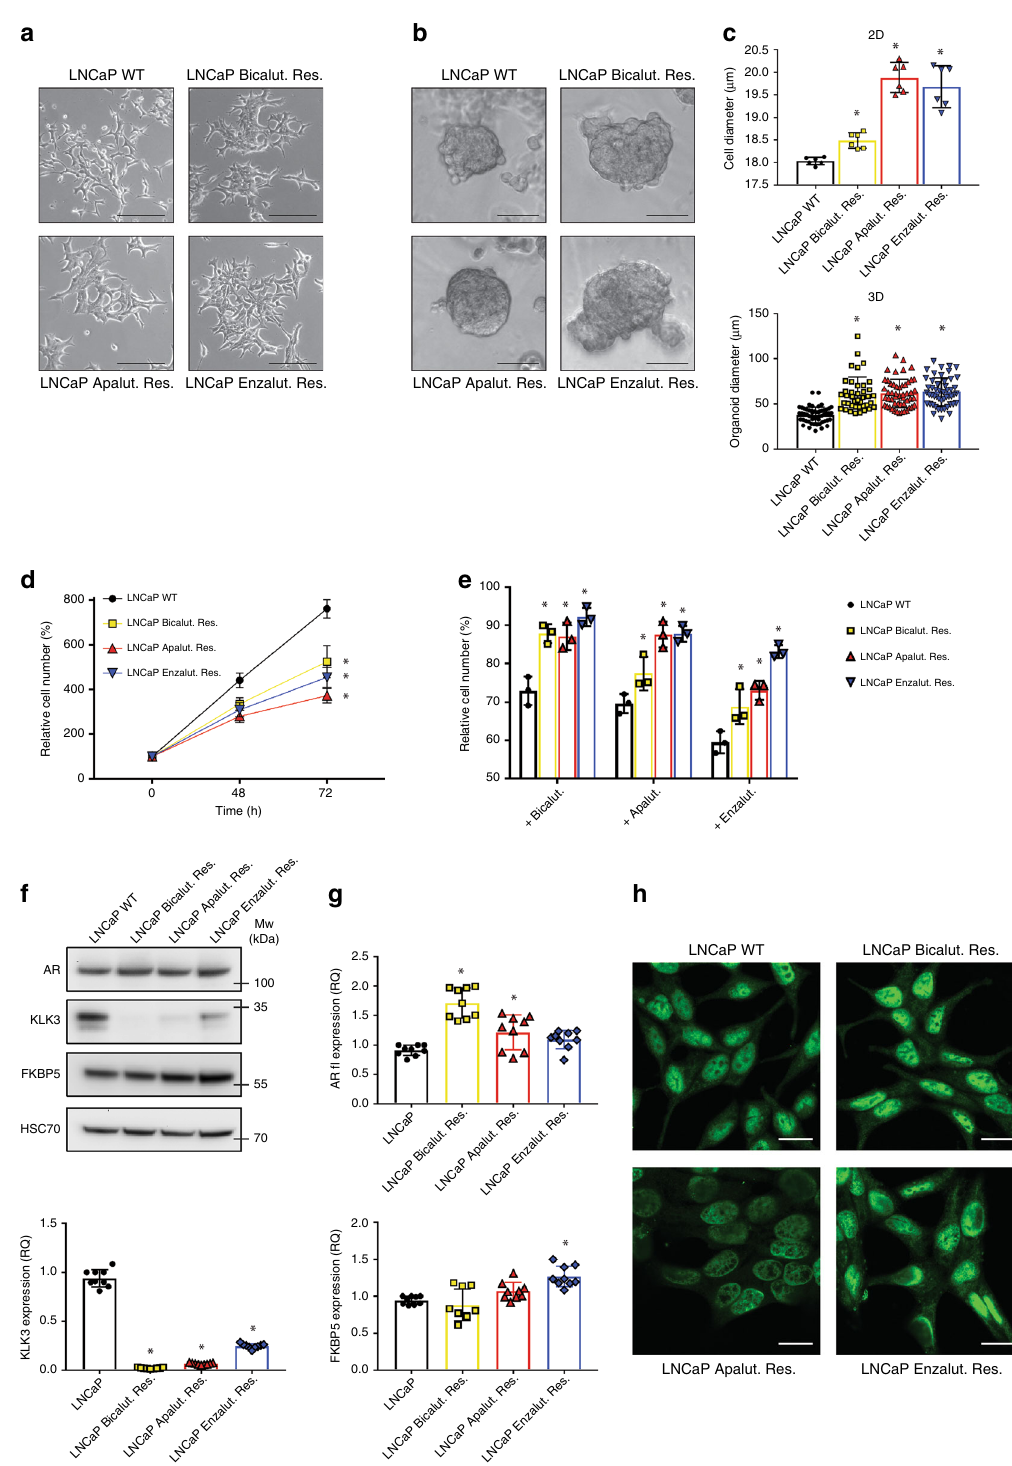
Fig. 1 AR signalling is conserved in ARI-resistant cells. a Representative pictures of WT and ARI-resistant LNCaP cells cultured in 2D conditions. Scale bar represents 100 µ m. b Representative pictures of WT and ARI-resistant LNCaP organoids embedded in Matrigel. Scale bar represents 50 µ m. c Quanti fi cation of cell (top panel) and organoid (bottom panel) diameter. d Cell proliferation of WT and ARI-resistant LNCaP cells after 48 and 72 h. Cell count is normalised to initial number of cells at T0. e Cell proliferation of WT and ARI-resistant LNCaP cells treated for 48 h with different AR inhibitors (10 µ M). Cell count is normalised to non-treated condition. f Western blot analysis of AR, KLK3 and FKBP5 expression in WT and ARI-resistant LNCaP cells. HSC70 was used as a sample loading control. g RT-qPCR analysis of AR (full length, fl ), KLK3 and FKBP5 expression in WT and ARI-resistant LNCaP cells. CASC3 was used as a normalising control . h Immuno fl uorescence showing nuclear AR expression in WT and ARI-resistant LNCaP cells. Scale bar represents 20 µ m. c – e , g Data are presented as mean values + / − SD. c , g * p -value < 0.05 using a 1-way ANOVA with a Dunnett ’ s multiple comparisons test. d , e * p -value < 0.05 using a 2-way ANOVA with a Tukey ’ s multiple comparisons test. Source data are provided as a Source Data